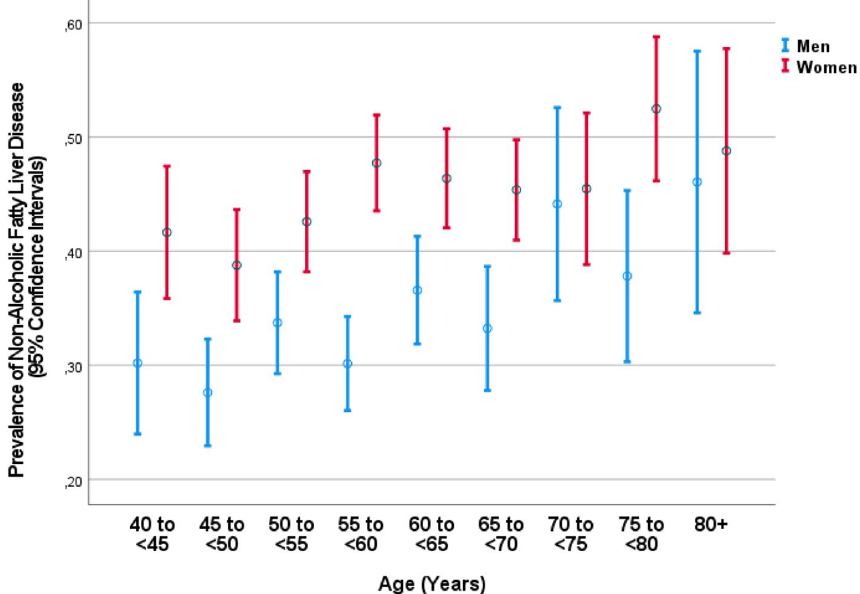
Figure 1. Graph showing the distribution of the prevalence of non-alcoholic fatty liver disease in the Ural eye and Medical Study, stratified by age and